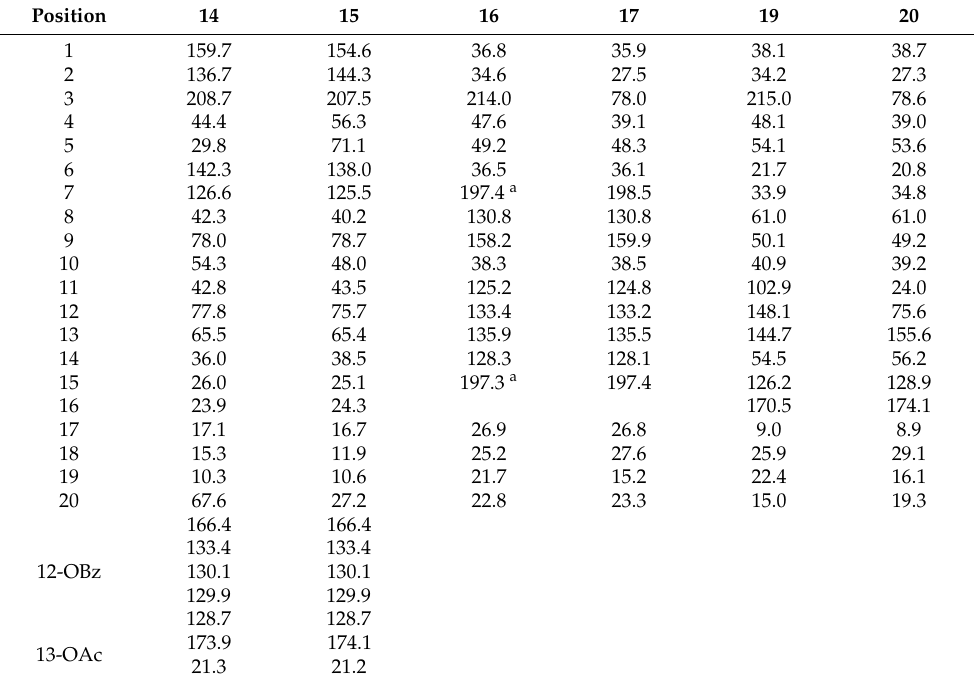
Table 5. 13 C NMR data of compounds 14 – 17 , 19 , and 20 in CDCl 3 at 125 MHz ( δ C in